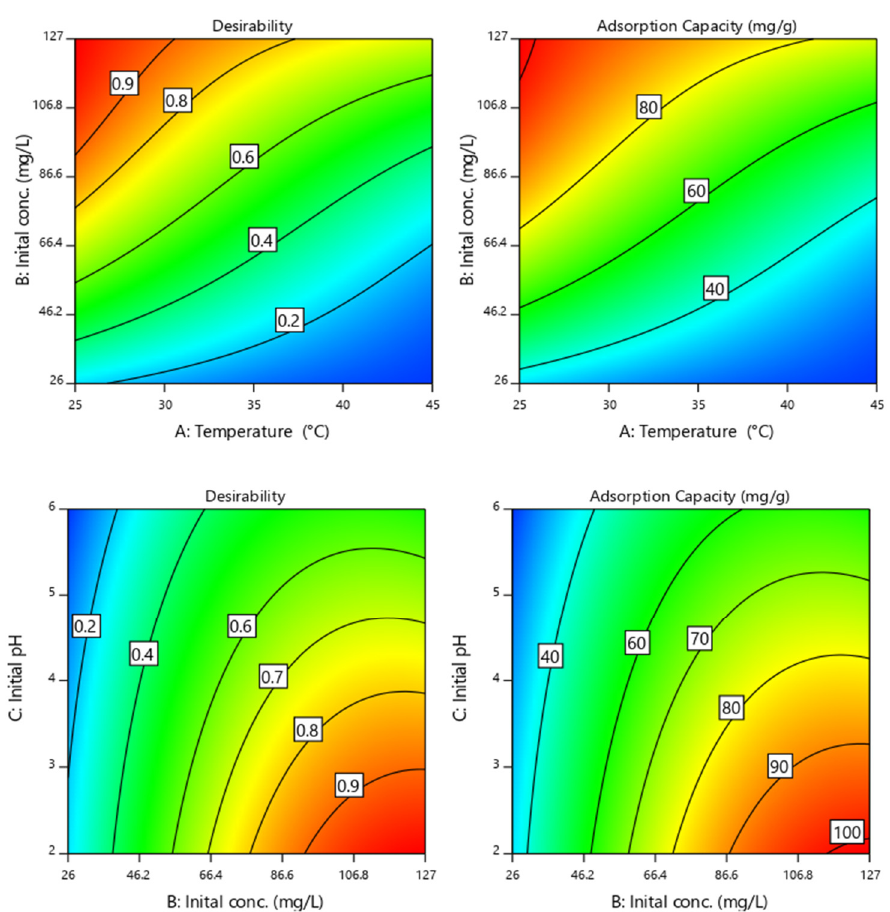
Figure 8. Desirability conditions for maximizing uptake capacity for Cr(VI) removal from water and finding optimal solutions.